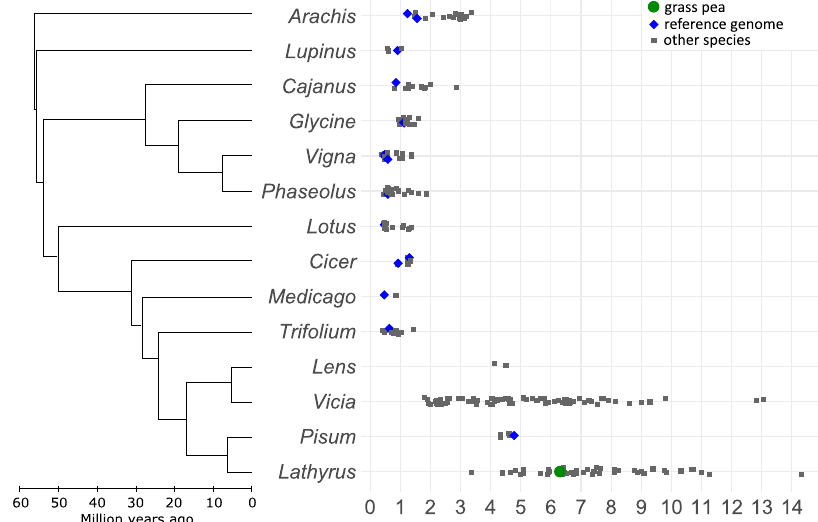
Fig. 5 | Phylogenetic tree and haploid genome sizes of selected legume genera. Phylogeny based on Lavin et al. 59 . Grass pea genome size based on this study, other genome sizes based on Kew c-value database 52 . Source data are provided as a Source Data fi